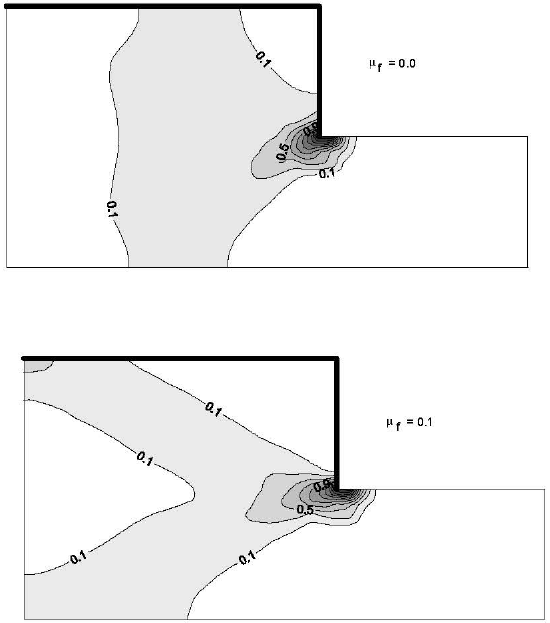
Fig. 4. Equivalent strain-rates at friction coefficients µ f = 0.0 and µ f = 0.1 .